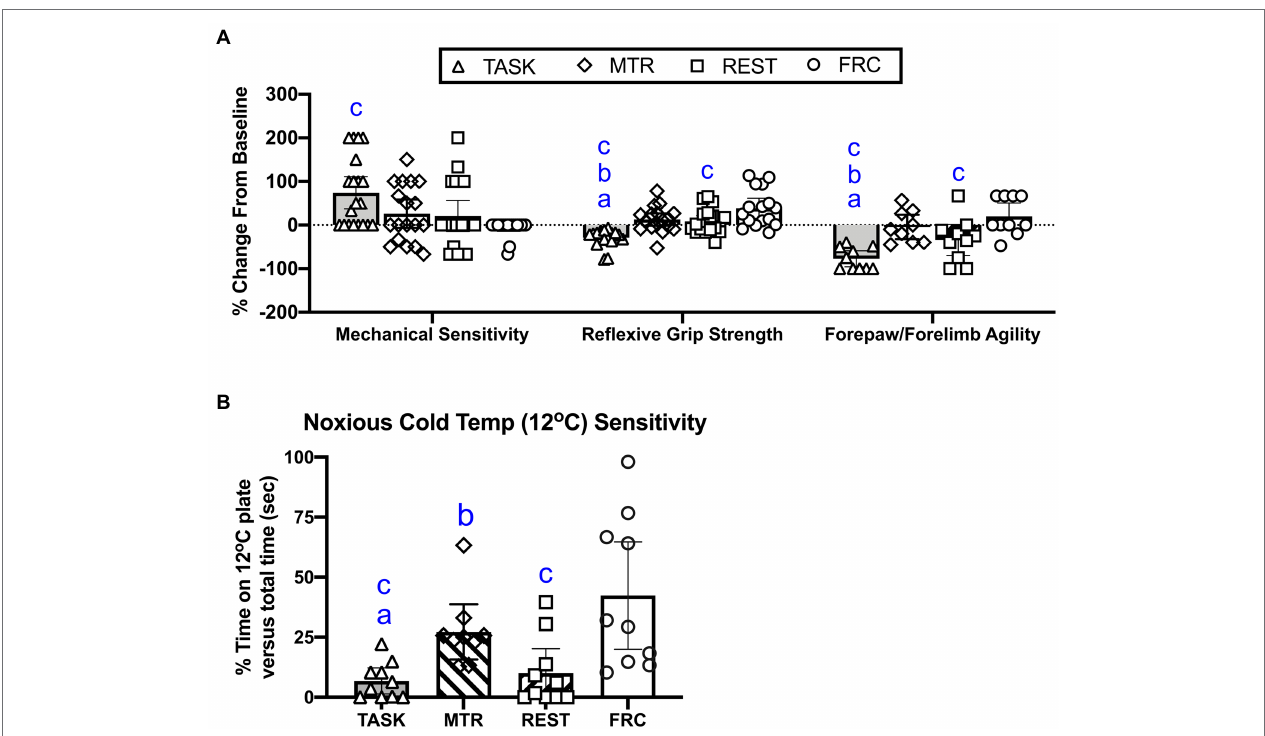
FIGURE 2 | Sensorimotor behavioral changes. (A) From left to right, percent change from baseline in forepaw mechanical sensitivity to probing with a 1 g monofilament, reflexive grip strength, and forepaw/forelimb agility. (B) Sensitivity to 12 ° C. Symbols: a , b , and c : p < 0.05 each, compared to MTR, rest alone (REST), and Food restricted control (FRC) groups, respectively. Mean ± 95% CI